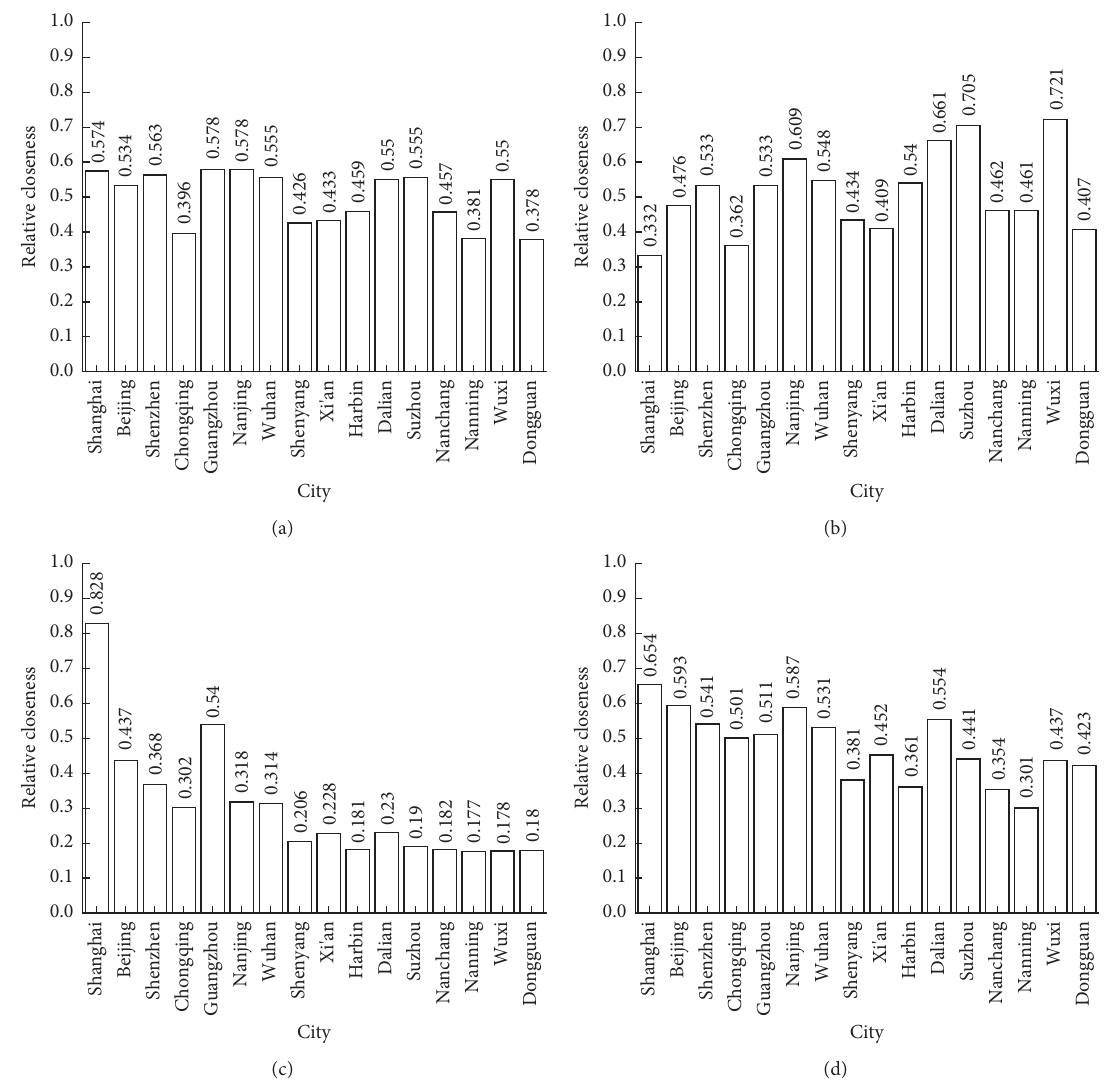
Figure 3: The relative closeness of different indicators in different cities: (a) public welfare, (b) policy loss, (c) social benefit, and (d) service